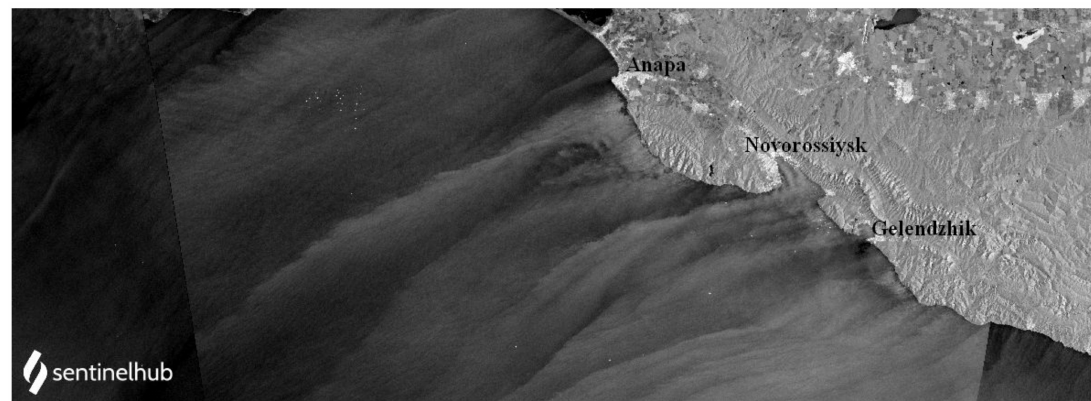
Figure 12. The impact of Novorossiysk bora on the coastal zone of the northeastern part of the Black Sea as revealed by Sentinel-1 SAR image on 5 August 2020. Grey bands propagating from the shoreline are a rough sea generated by the northeasterly wind. Ground length between Novorossiysk and Gelendzhik is 30